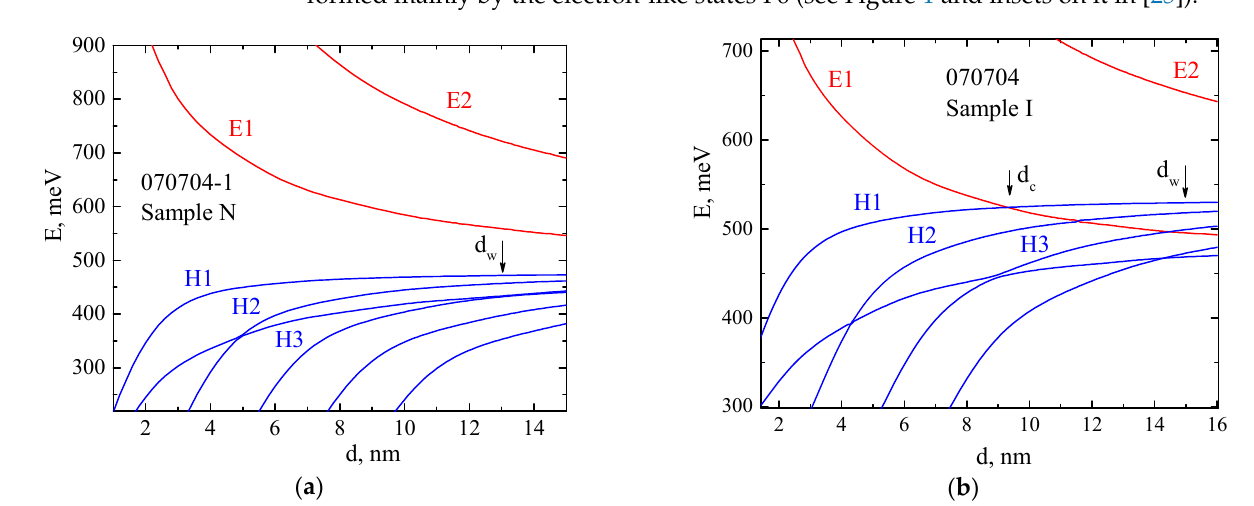
Cd t Te quantum well 1 − t